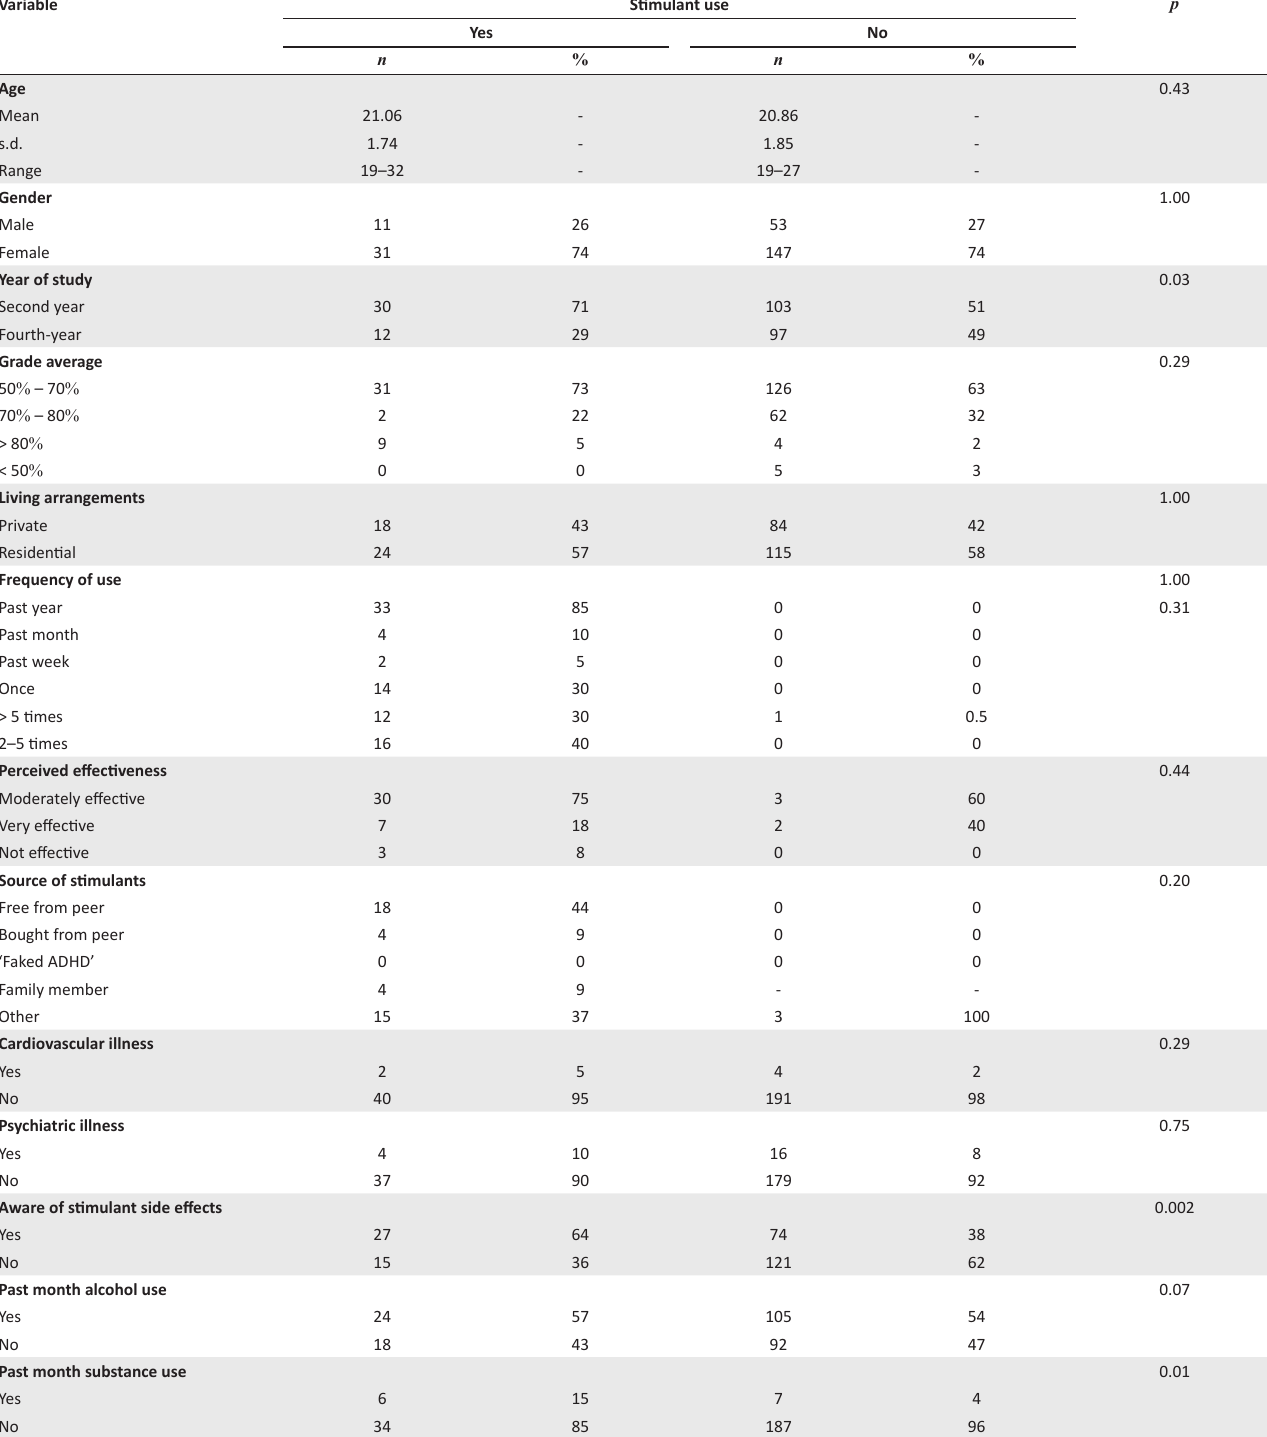
TABLE 2: Correlates of non-medical stimulant use in undergraduate medical students. † Variable Stimulant